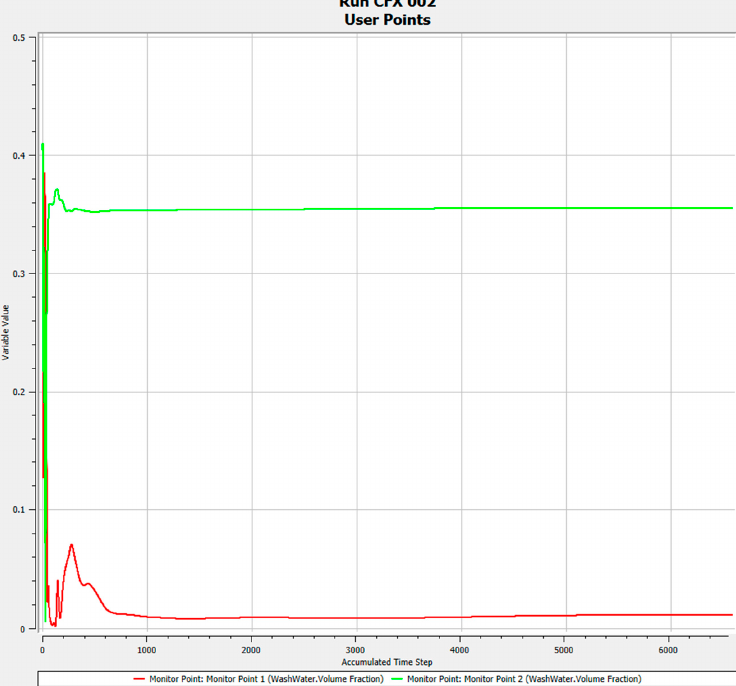
Figure 8. Volume fraction plot for convergence check (initial mesh).